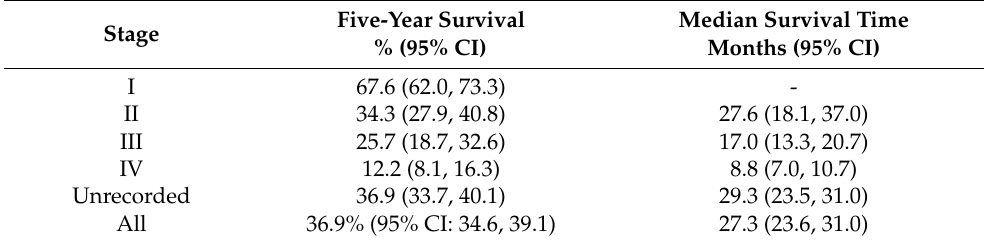
Table 2. Five-year observed survival and median survival time for bladder cancer patients in Malaysia.